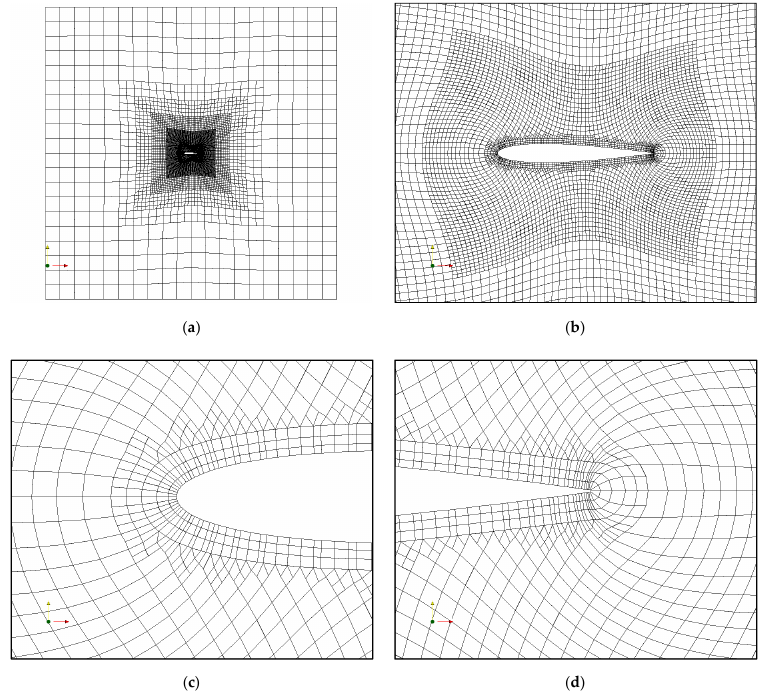
Figure 5. Deformed mesh using the inverse distance weighted (IDW) method. ( a ) whole domain (side view), ( b ) near body (side view), ( c ) around leading edge (side view), ( d ) around leading trailing (side view).